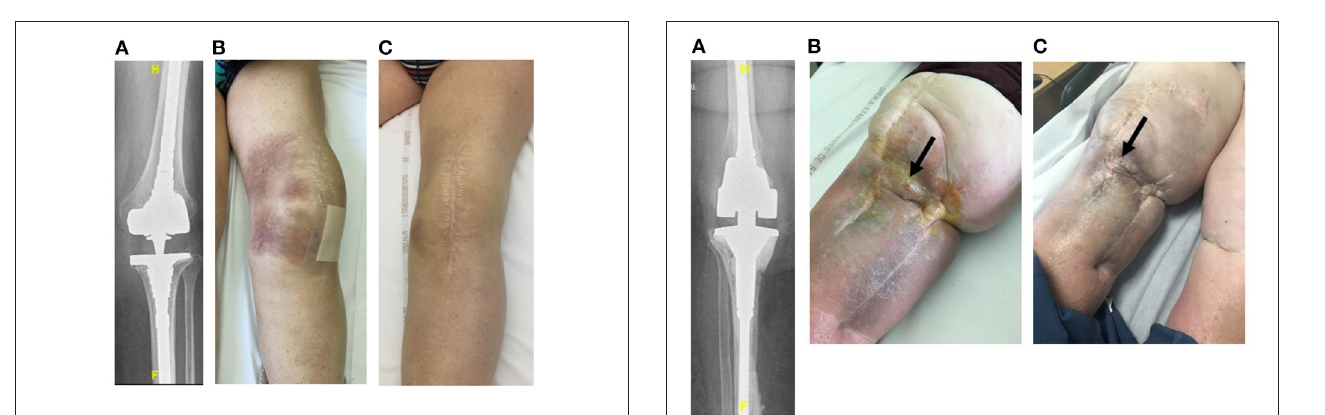
FIGURE 2 | Patient 2 was a 79-year-old man with history of severe ankylosing spondylitis under corticosteroids who presented a chronic left PKI due to S. hominis that was treated with a one-stage exchange. A postoperative infection occurred due to MDR S. epidermidis (02/12/3013) treated with open DAIR and SAT (minocycline followed by cotrimoxazole due to occurrence of a clinical relapse under minocycline therapy; 10/11/2013). He had a cementless revision prosthesis with long stem with no loosening (A) and clinical signs of septic arthritis (large joint effusion, pain during mobilization, skin inflammation without sinus tract) (B) and S. epidermidis grew from joint puncture (9/13/2018). He was treated according to the LysinDAIR procedure (08/11/2018), and a septic collection communicating with the joint was drained. He received daptomycin intravenously and linezolid orally and experienced eosinophilic pneumonia attributed to daptomycin and diarrhea attributed to linezolid. Then, tedizolid was prescribed as SAT, and the outcome was favorable with disappearance of the clinical signs of septic arthritis (C) . At 12 months, as a mild joint effusion persisted, a joint puncture was performed, and surprisingly, S. epidermidis was still present in culture. At the time of writing (16 months of follow-up after the LysinDAIR procedure), the clinical outcome was still favorable under tedizolid therapy, and the patient was able to resume golf.